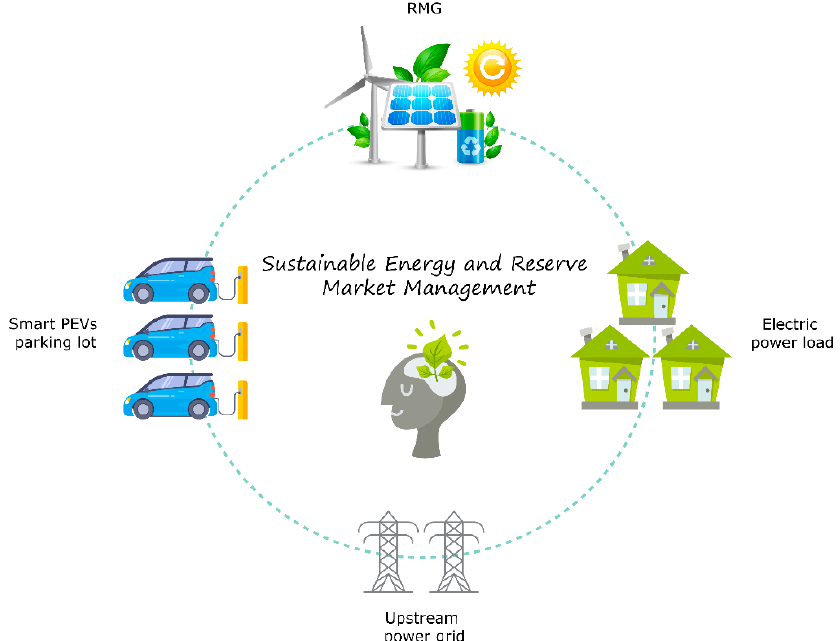
Figure 1. General superstructure for the sustainable energy and reserve market management in the renewable microgrid–plug-in electric vehicles parking lot (RMG-PEVs) system.